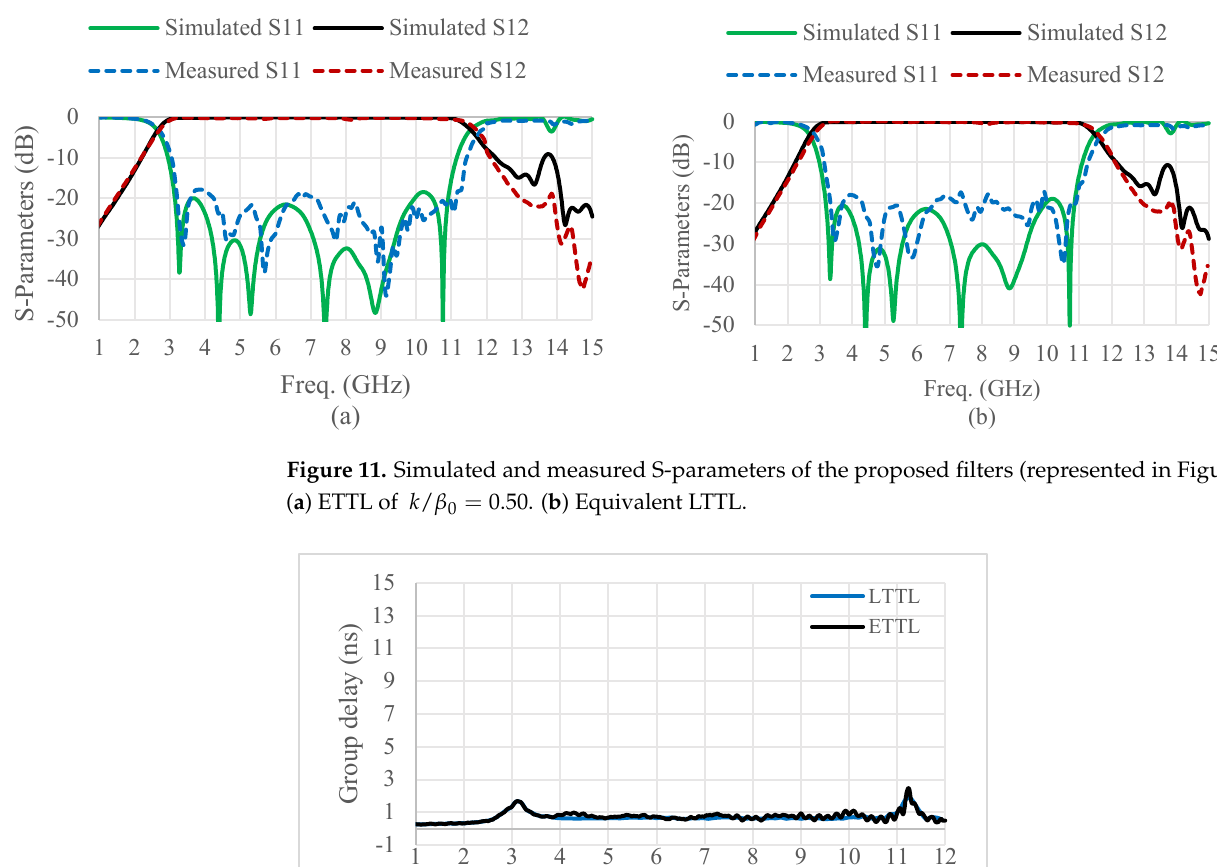
Figure 10. Simulated and measured S-parameters of the proposed filters (represented in Figure 6).